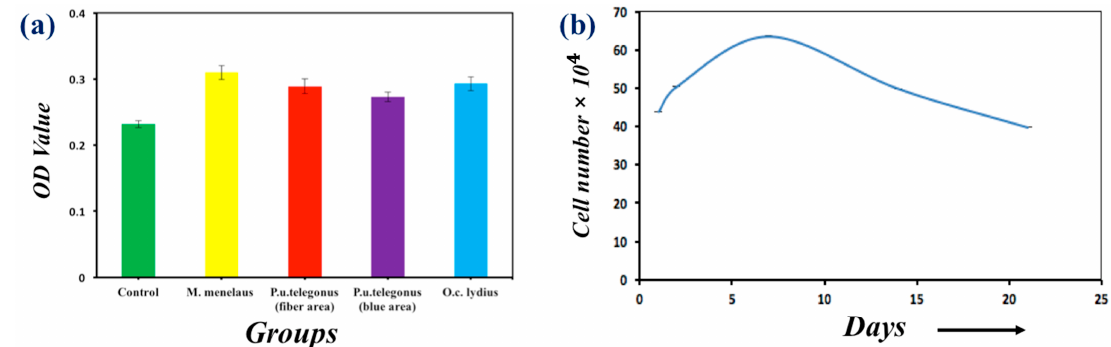
Figure 5. ( a ) MTT activity assay of NIH-3T3 fibroblast cells cultured on different substrates: M. menelaus , P. u. telegonus (blue area and fiber area), O. c. lydius and cell culture dish after 48 h. ( b ) A long period culture of NIH-3T3 fibroblast cells on an M. menelaus